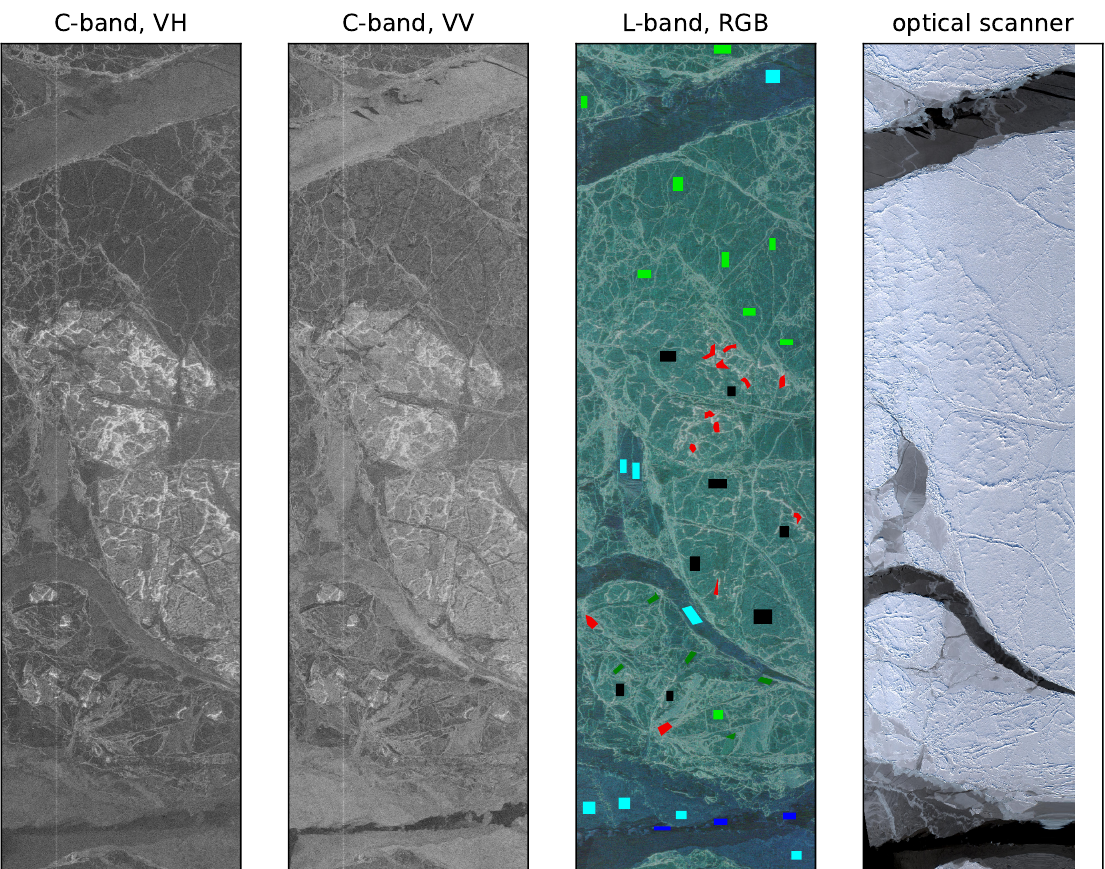
Figure 5. ICESAR dataset. From left to right: C-band VH, C-band VV, L-band false-color (R-HV, G-HH, B-VV), optical scanner. Colored boxes in the L-band image indicate training regions for different classes. Table 1. Classes defined from visual inspection of the ICESAR dataset, with corresponding color codes and number of samples. Description Color Code # Training